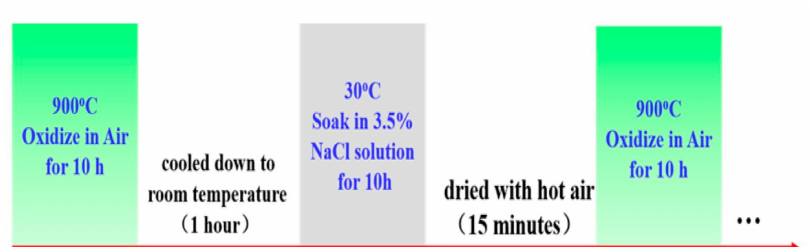
Figure 1. Schematic of the experimental cycles: alternating oxidation (at 900 ◦ C) and solution emersion (in 3.5% NaCl solution, 30 ± 1 ◦ C).